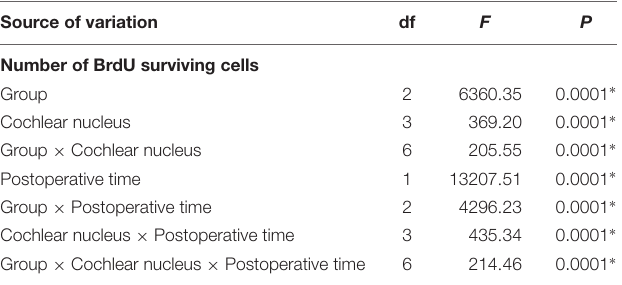
TABLE 3 | Statistical analysis of the survival of newly generated cells by comparing cats receiving BrdU injection 3 days after UCN and perfused 3 h after (protocol 1) and those receiving BrdU at the same time but perfused 27 days after (protocol 2).